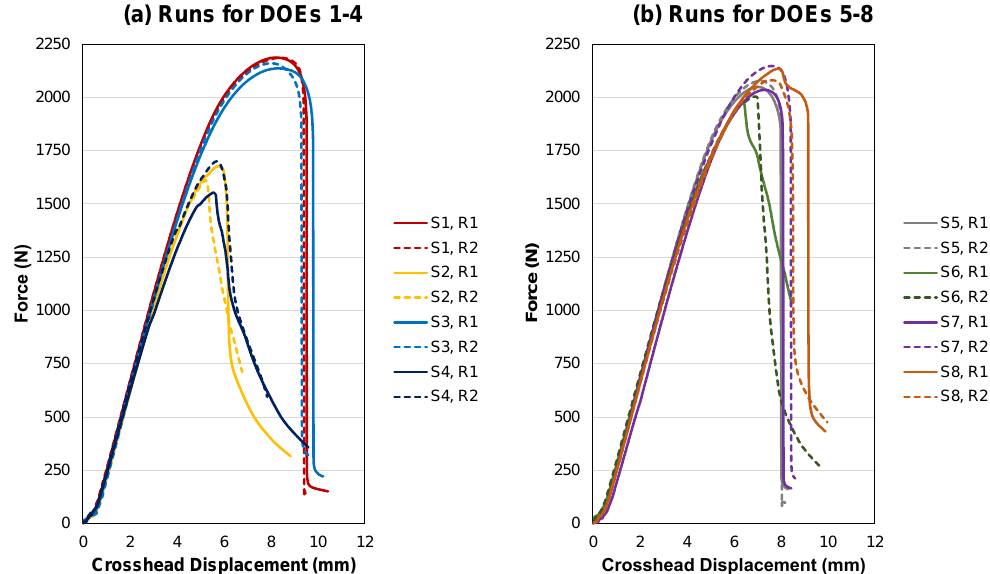
Figure 11. Force–deflection curves from the three-point bending test for both replications of the experiment, divided into two plots for clarity. Runs 1–4 are shown in ( a ). Runs 5–8 are shown in ( b ). The plot legend indicates [Sample, Replication] in each case. Table 3. Experimental responses. See Table 2 for factor levels and combinations. SE = σ /